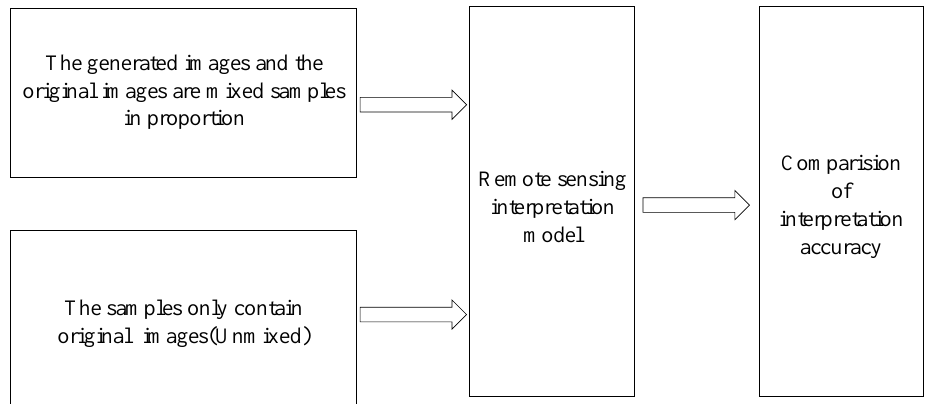
Figure 14. Flow chart of the